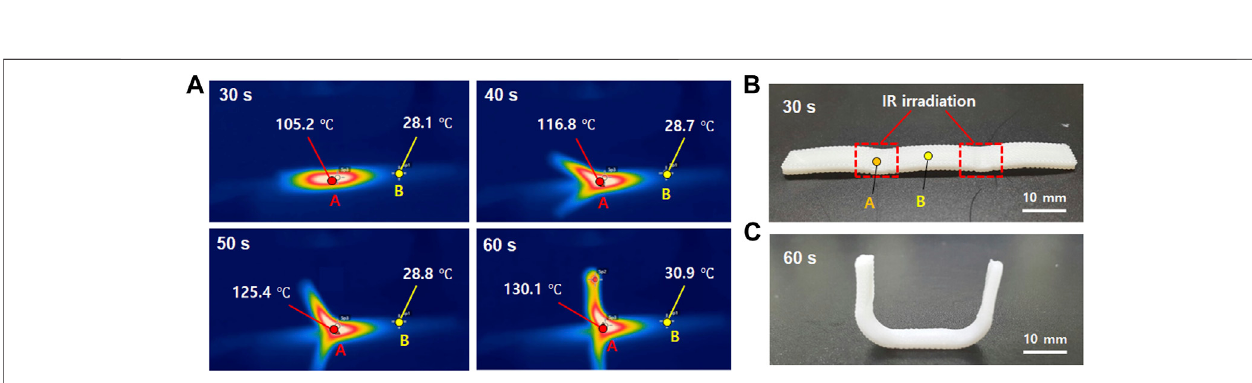
Frontiers in Materials |